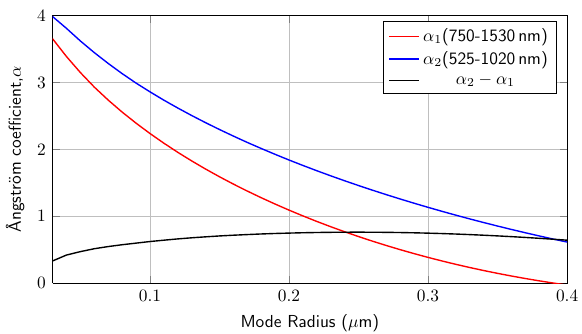
Fig. 16. Comparison of the OSIRIS and SAGE II Ångström coefficients as a function of mode radius for a log-normal distribution with a mode width of 1.6